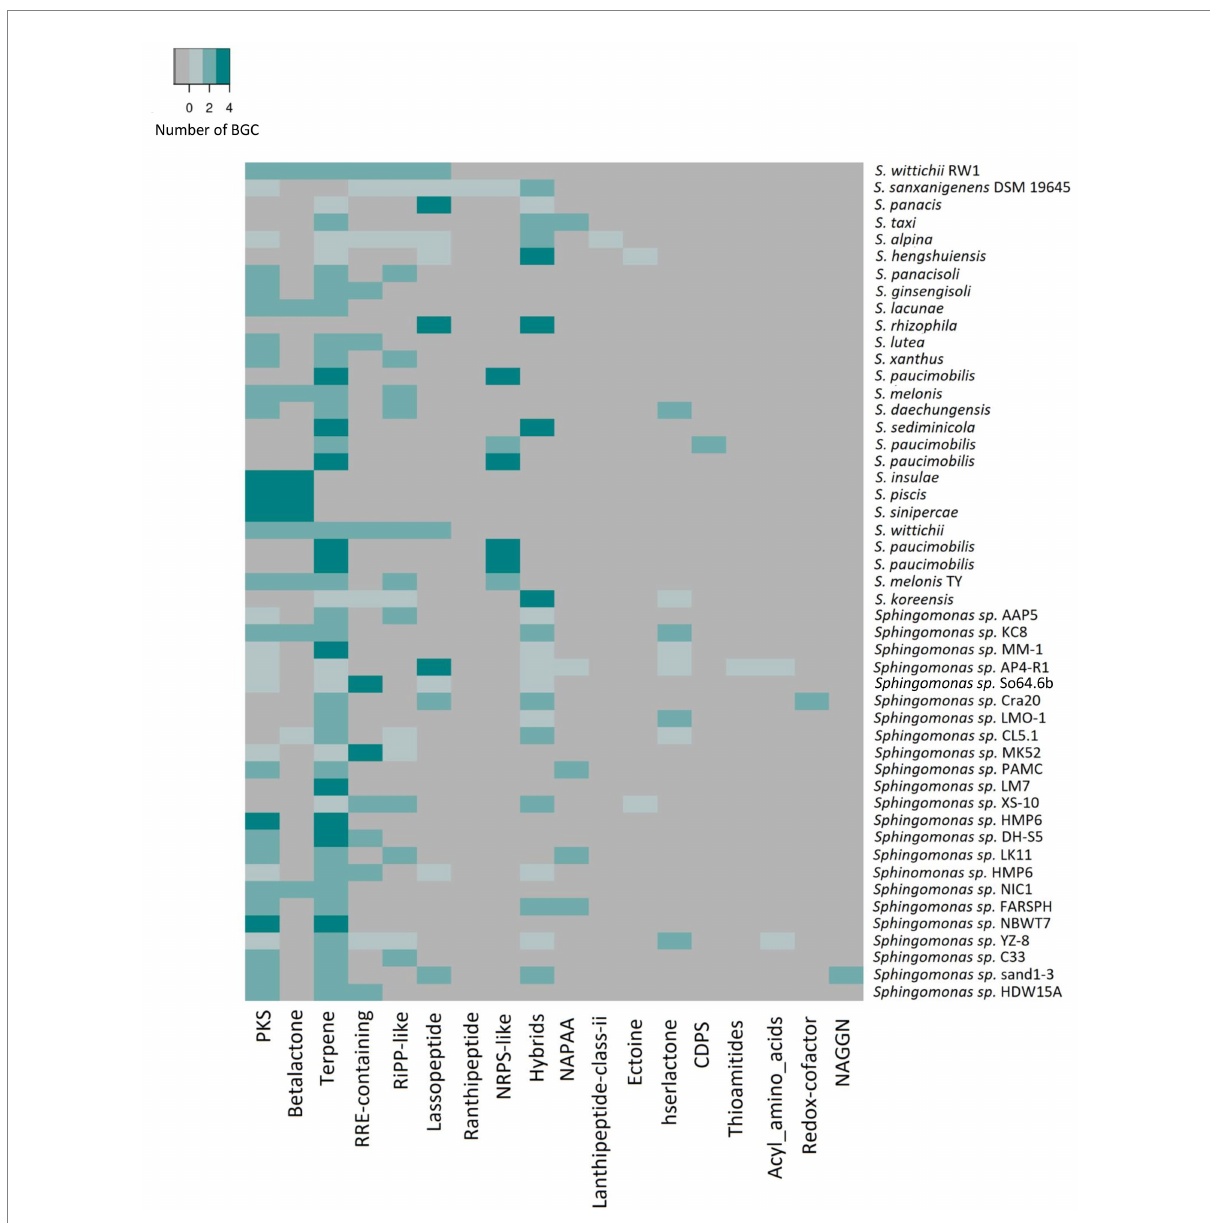
FIGURE 4 Heatmap of number and types of BGCs predicted by AntiSMASH analysis for 49 representative genomes of Sphingomonas genus, including the Antarctic strain So64.6b. The color scale represents the number of counts per type of BGC found on the